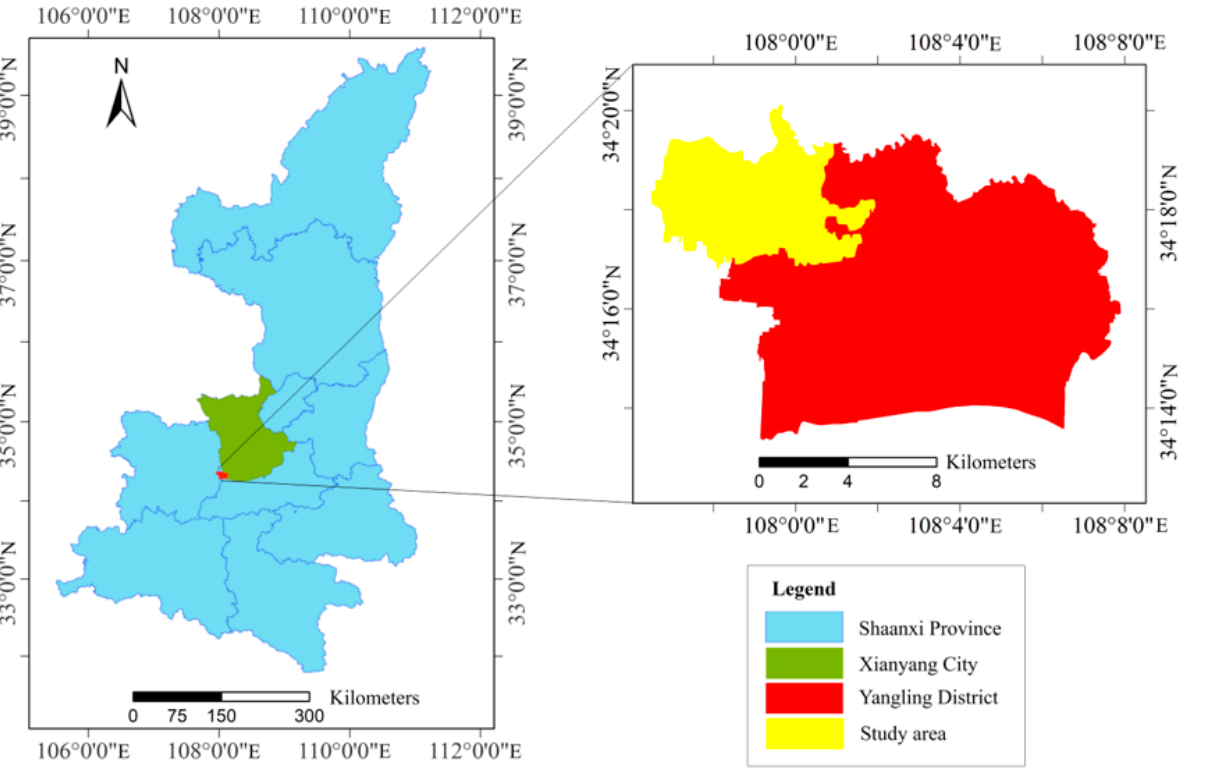
Figure 1. Location of study area.